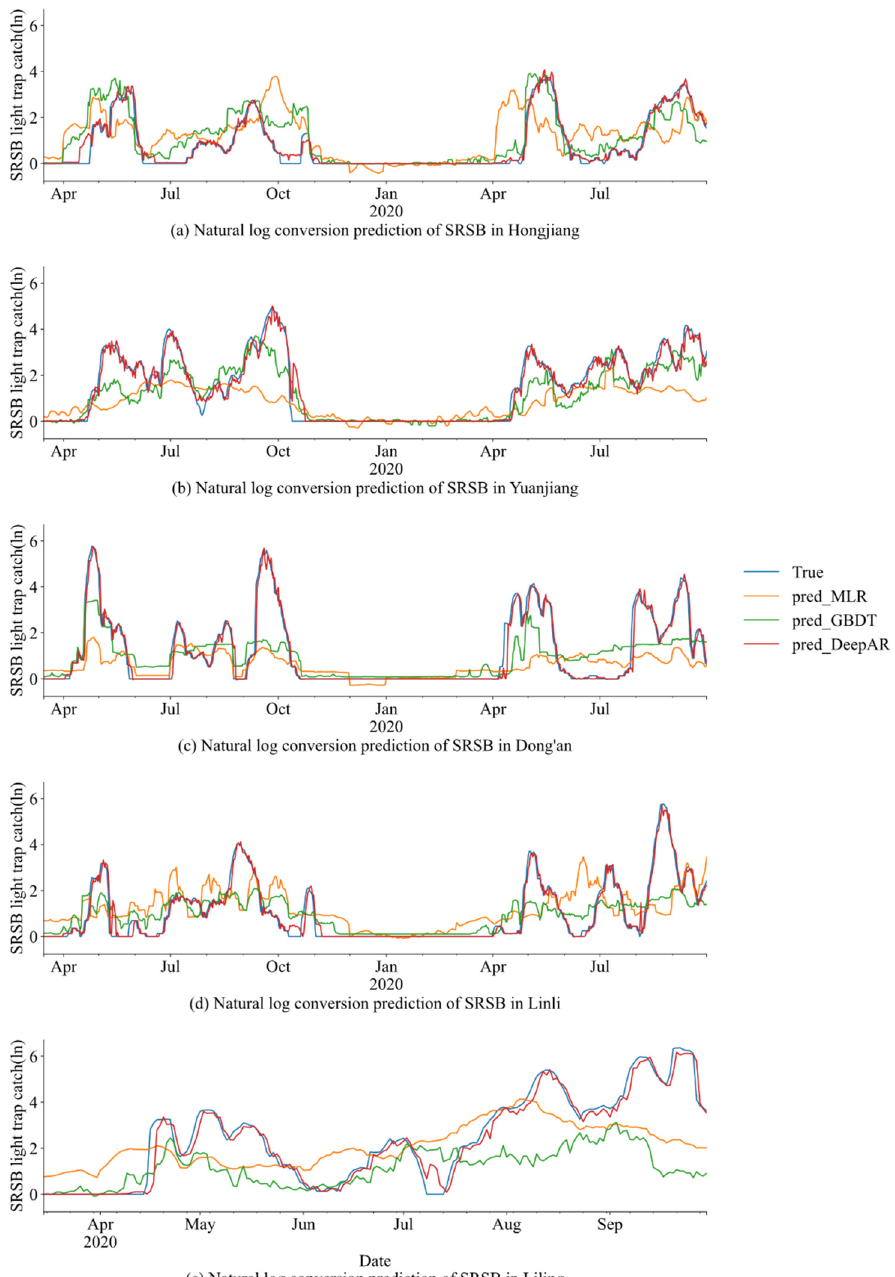
Figure 5. Predicted results of the SRSB light trap catches from the test datasets using the MLR, GBDT, and DeepAR models.